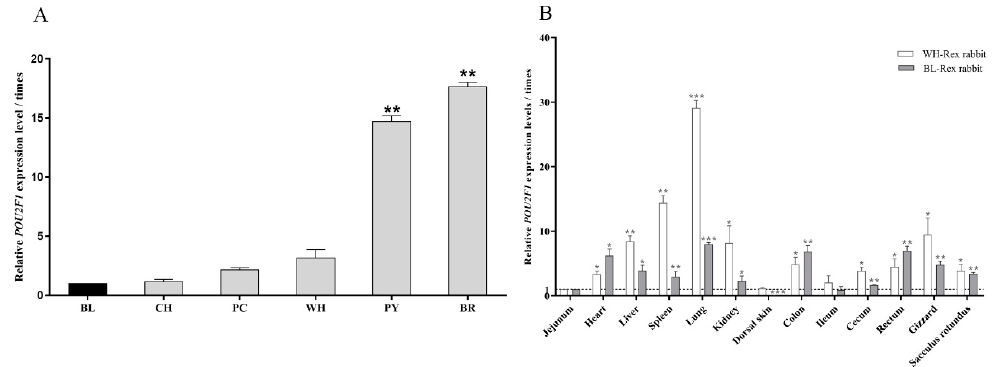
Figure 2. Expression patterns of POU2F1 gene. ( A ) The expression level of POU2F1 in the dorsal skin of Rex rabbits with different fur colors. BL: black, CH: chinchilla, WH: white, BR: brown, PY: protein yellow, and PC: protein chinchilla. POU2F1 expression levels in the dorsal skin of the black Rex rabbit were used as the control to calculate the relative expression levels in Rex rabbits of other colors in figure A. ( B ) The expression level of POU2F1 in different organ tissues of the white and black Rex rabbit. POU2F1 expression levels in jejunum of the white and black Rex rabbit were used as controls for calculating the relative expression level in corresponding Rex rabbits in figure B. * p < 0.05, ** p < 0.01, and *** p <